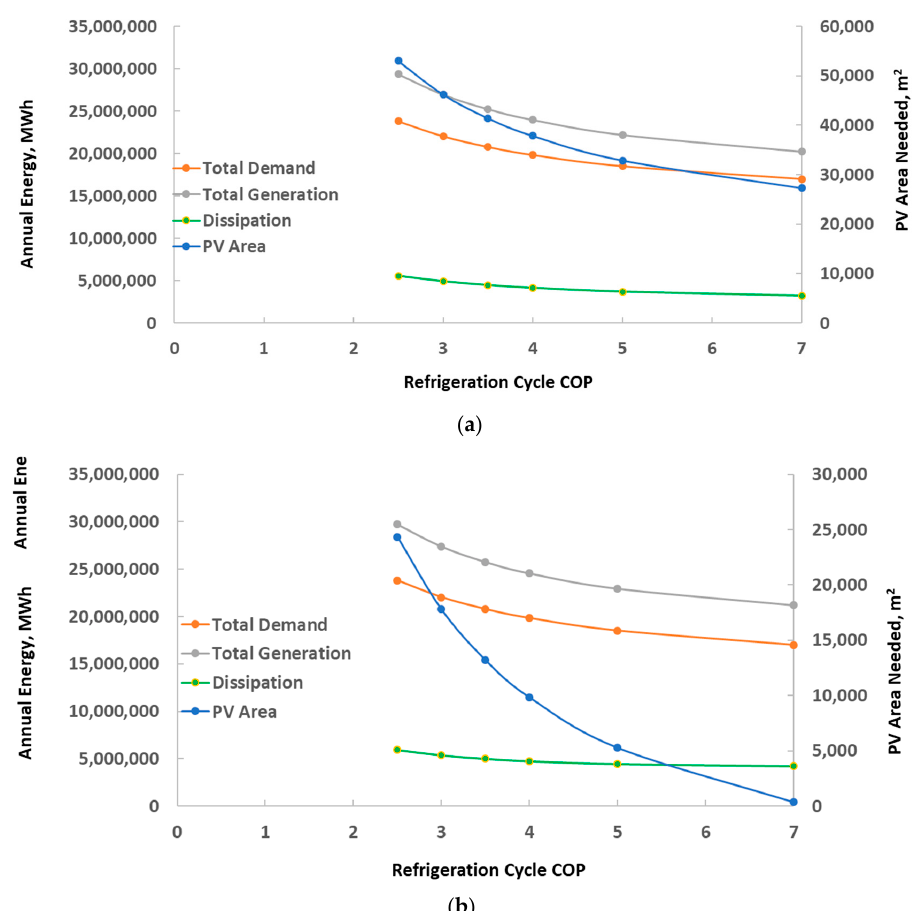
Figure 3. ( a ) Photovoltaics area needed, annual energy demand, supply, and dissipation as a function of the COP when one wind turbine is employed. ( b ) Photovoltaics area needed, annual energy demand, supply, and dissipation as a func- tion of the COP when two wind turbines are